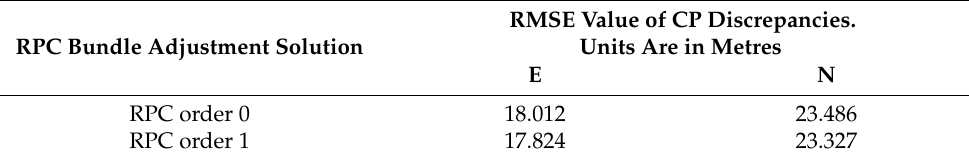
Table 10. Results of RPC bundle adjustment with bias compensation for small area of the image in the lower right corner, test field of Fucino.